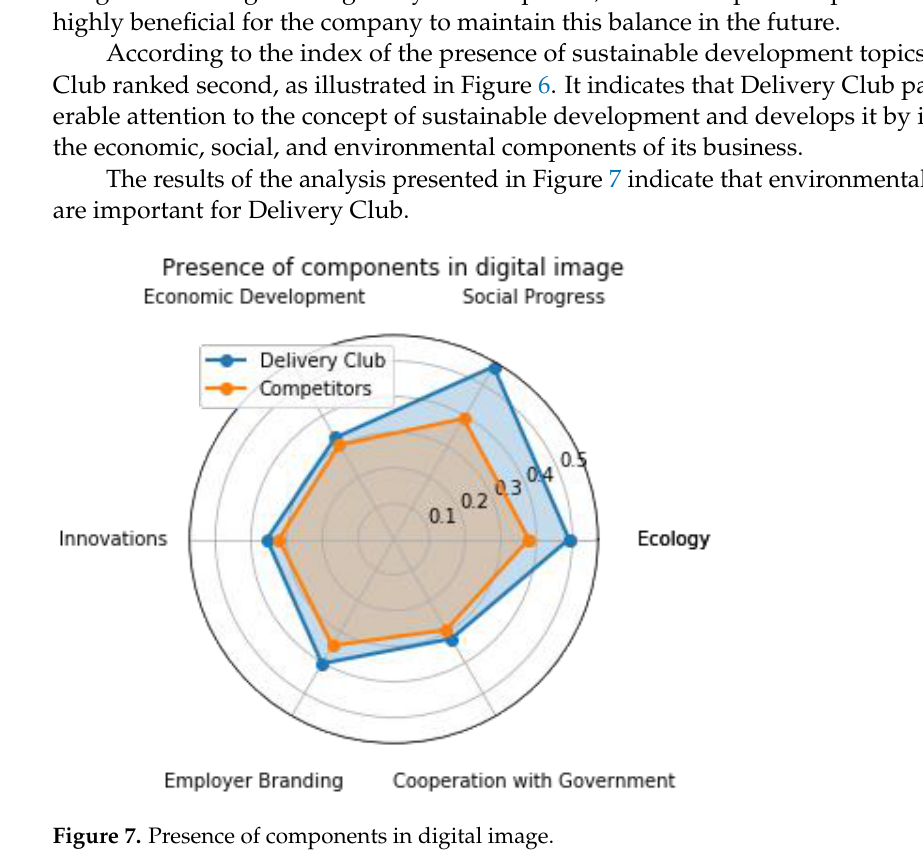
Figure 7. Presence of components in digital image.